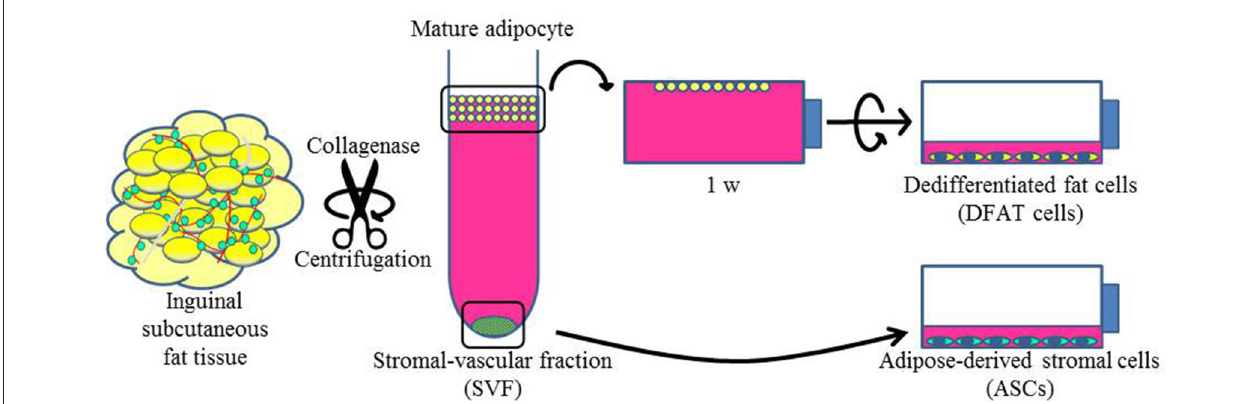
FIGURE 1 | Isolation of DFAT cells and ASCs. The upper section shows the method used to isolate DFAT cells from floating unilocular adipocytes. The floating cells were attached to the upper surface of the flasks and then DFAT cells emerged by asymmetrical division of floating cells for 1 week. The lower section shows the method used to isolate ASCs. After centrifugation, the SVF fraction was separated by sedimentation from floating cells and the SVF fraction was cultured for isolation of